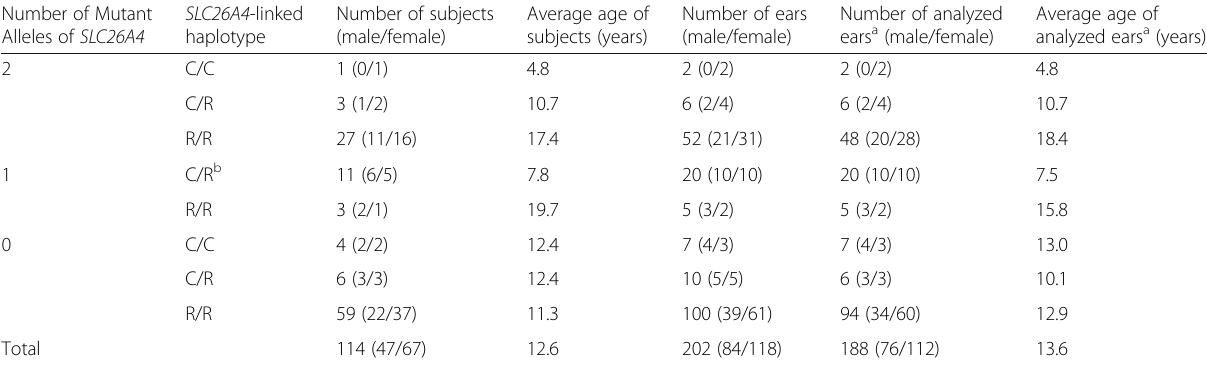
Table 1 Study subject demographics Number of Mutant Alleles of SLC26A4